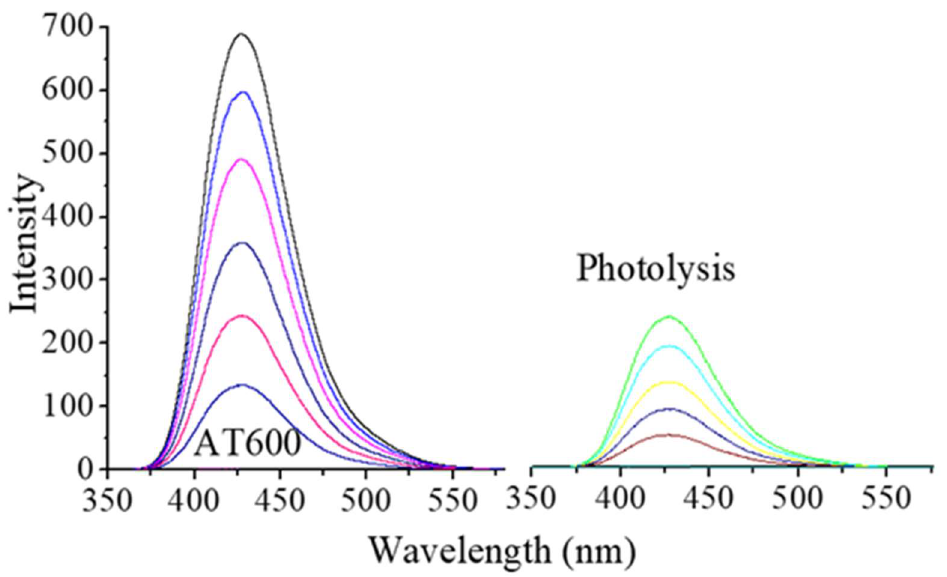
Figure 7. Fluorescence spectra of terephthalic acid during irradiation of the AT600 photocatalyst under UV light for 1.5 h and photolysis.